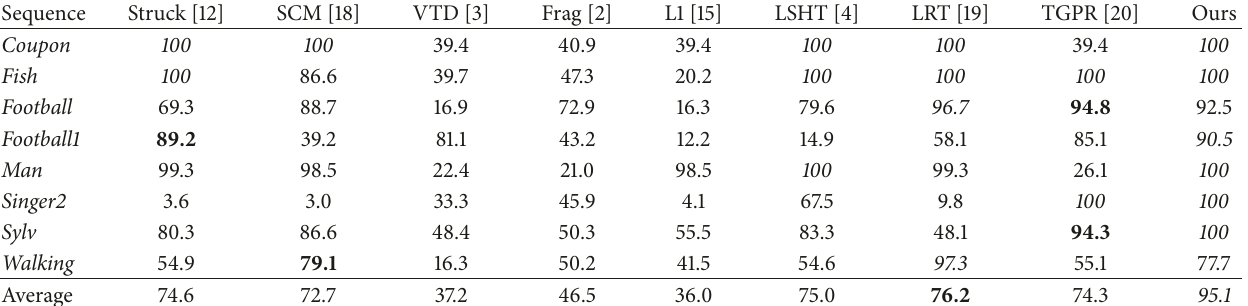
Table 4: Success rates (%). The best two results are shown in italic and bold colors, respectively. Sequence